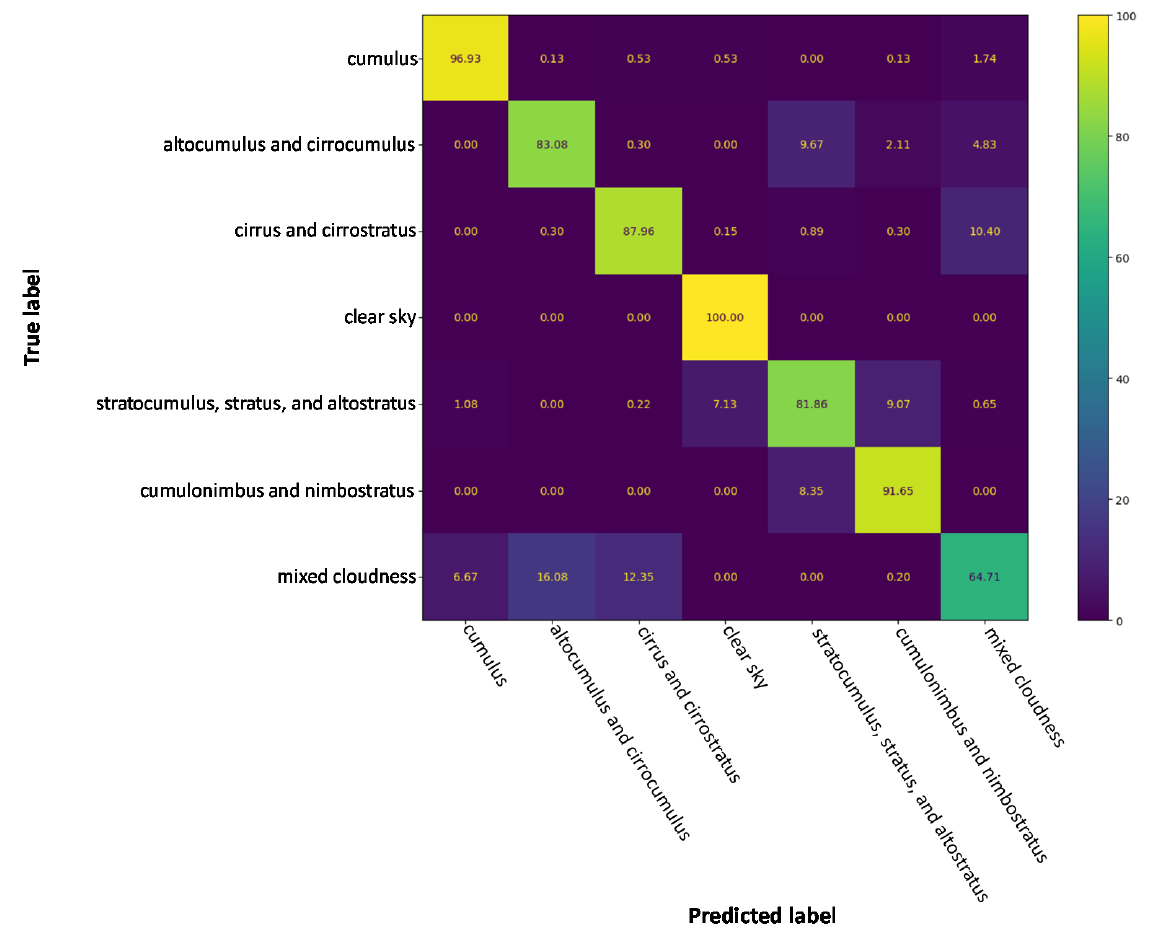
Figure 6. The confusion matrix for late fusion pixel-CNN and SIFT-CNN (Resnet 18)-SVM for the GRSCD dataset.